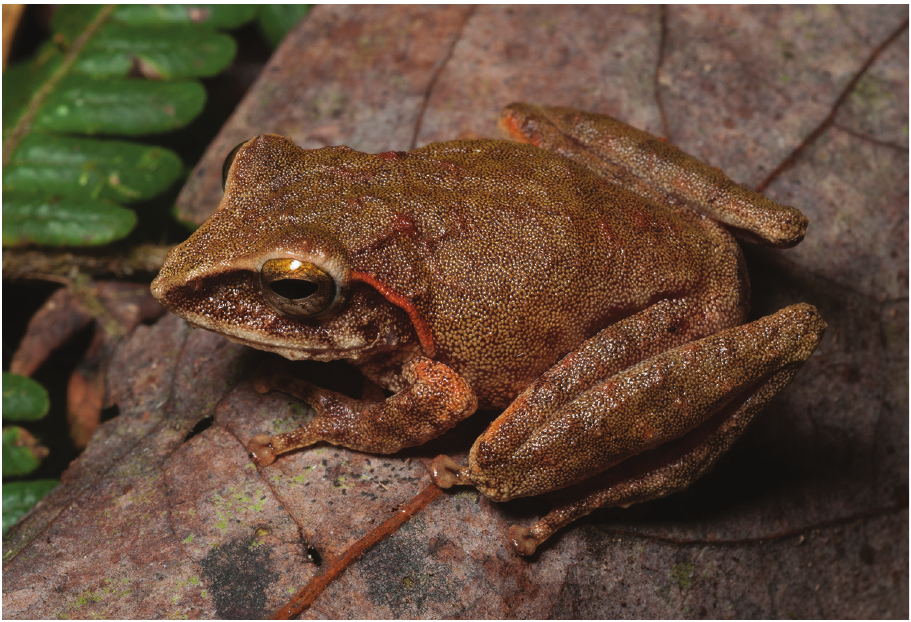
Figure 29. Philautus acutirostris female (KU 334110) from May-Impit, Mt. Hilong-hilong, Municipality of Remedios T. Romualdez, Agusan del Norte Province. Photo: